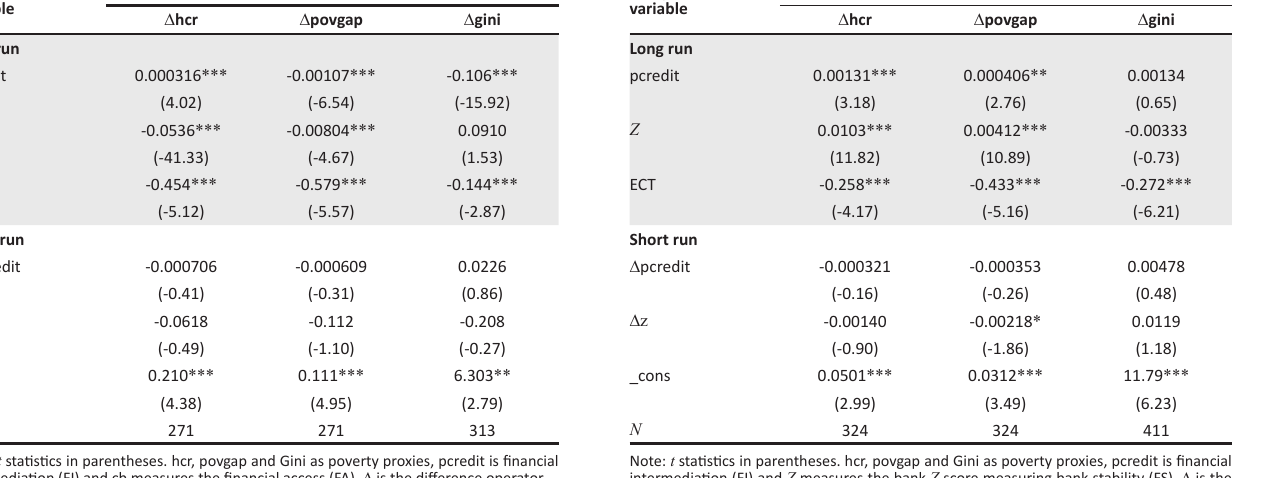
TABLE 2: Summary of the pooled mean group on the cointegration of poverty proxies and financial intermediation and financial access. Independent variable